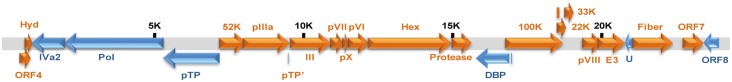
Putative genetic content of penguin adenovirus.The range of entire genome lengths of penguin adenoviruses were 24,630–24,662 bp, and the putative sialidase gene was not detected in the penguin adenovirus genomes. The genomic lengths are indicated at5,000 bp intervals.